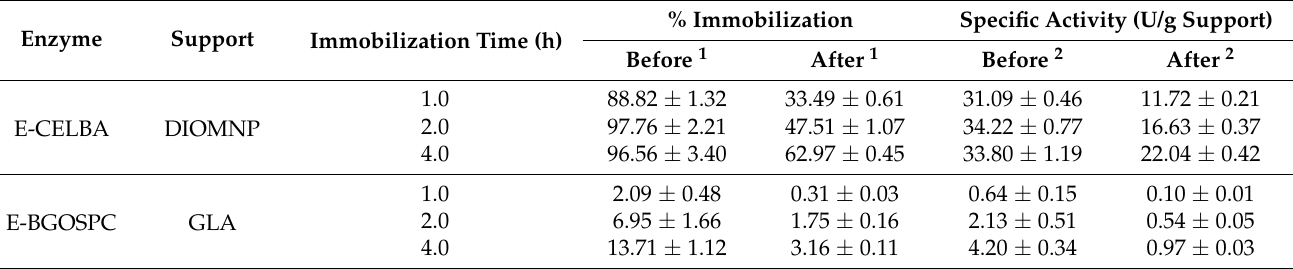
Table 1. Effect of immobilization time on different supports and reduction with NaBH 4 on enzyme activity, pH 10.0, at room